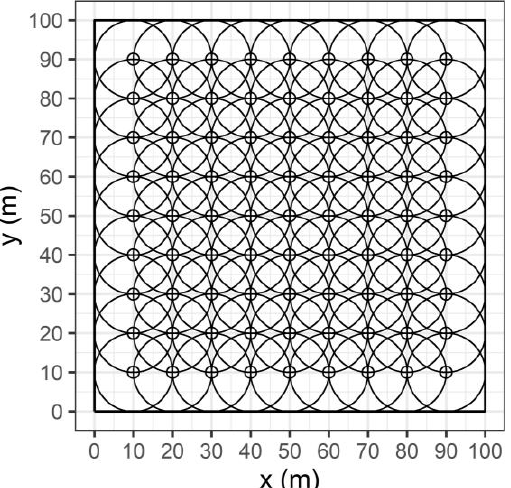
Figure 5. Subplots (large circles) and LAI measurement points (small circles) in the study plot. The ANPPW and the number of trees (understory and total) within each subplot were calculated. Pearson’s correlation coefficients ( r ) between canopy LAI and the ANPPW and between the ANPPW and the number of trees in the subplot were calculated. To investigate the relationship between community structure and canopy LAI, the relative dominance of each species was calculated in each subplot and compared with canopy LAI.